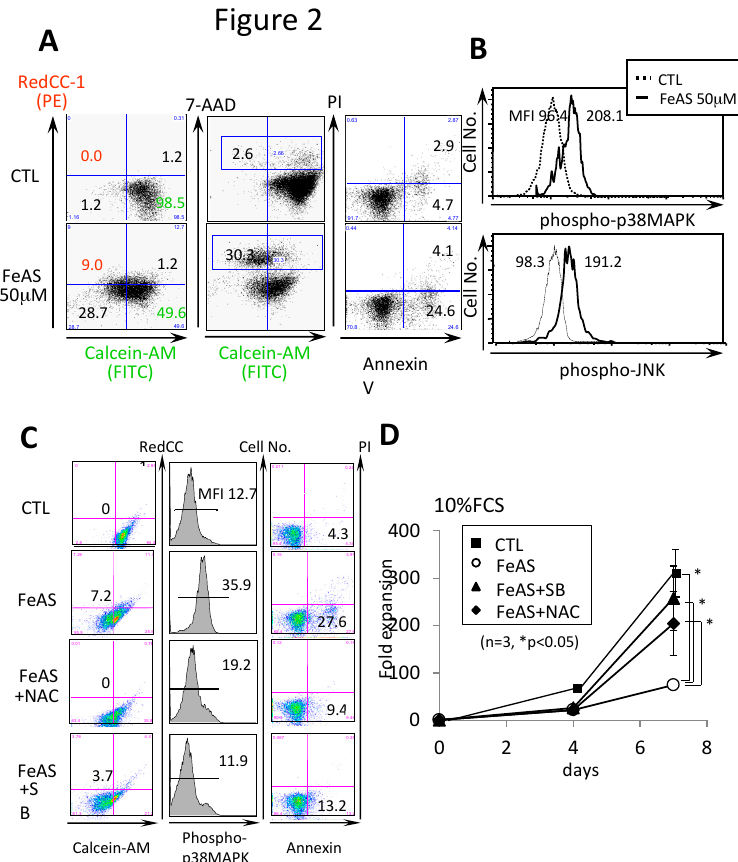
Figure 2. FeAS induces growth inhibition and cell death through reactive oxygen species (ROS)-activated p38MAPK. ( A ) After 72 h of culture with or without FeAS, LSK cells were stained with Calcein-AM and Red CC-1 and subjected to flow cytometry analyses. Intracellular labile iron and total ROS were detected with Calcein-AM and Red CC-1, respectively. FeAS-induced cell death was assessed as Calcein-AM low/negative and 7-AAD positive staining. The percentage of 7-AAD positive dead cells is indicated by the number in the quadrant. ( B ) After 72 h of culture with or without FeAS, cells were stained with specific antibodies, and threonine and tyrosine phosphorylation of p38MAPK and JNK/SAPK was examined by FACS. ( C ) Effects of the anti-oxidant (N-Acetyl- L -cysteine, NAC) and p38MAPK inhibitor (SB203580, SB) on ROS-accumulation (left panel), phosphorylation of p38MAPK (middle panel), and the type and stage of cell death (right panel) was examined by FACS. LSK cells were cultured with 50 µ M of FeAS in combination with either 100 µ M NAC or 10 µ M SB203580 for 72 h. The percentage of Calcein-AM low/RedCC1+ fraction, mean fluorescence intensity (MFI) of phosphor-p38MAPK, and annexinV+/PI- apoptotic fraction are indicated, respectively. ( D ) Effects of NAC and SB on FeAS-induced growth inhibition of LSKs were evaluated. Data is shown as the means ± SD of summarized data obtained from three independent experiments (* p < 0.05).